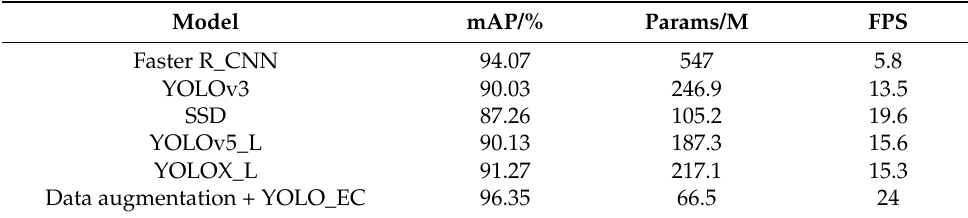
Table 4. Comparison of the detection performance of different target detection